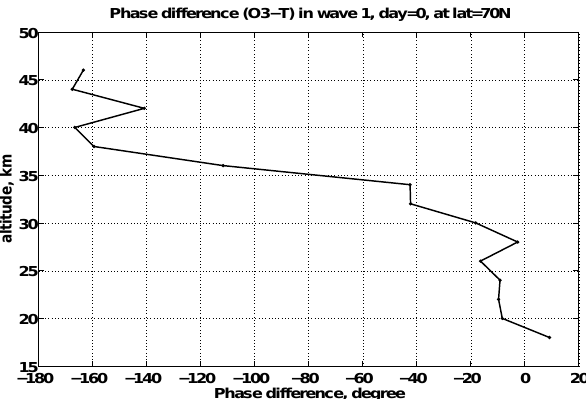
Fig. 7. Phase difference between the wavenumber one in ozone and in temperature on 1 January 2003 (day 0) at latitude=70 ◦